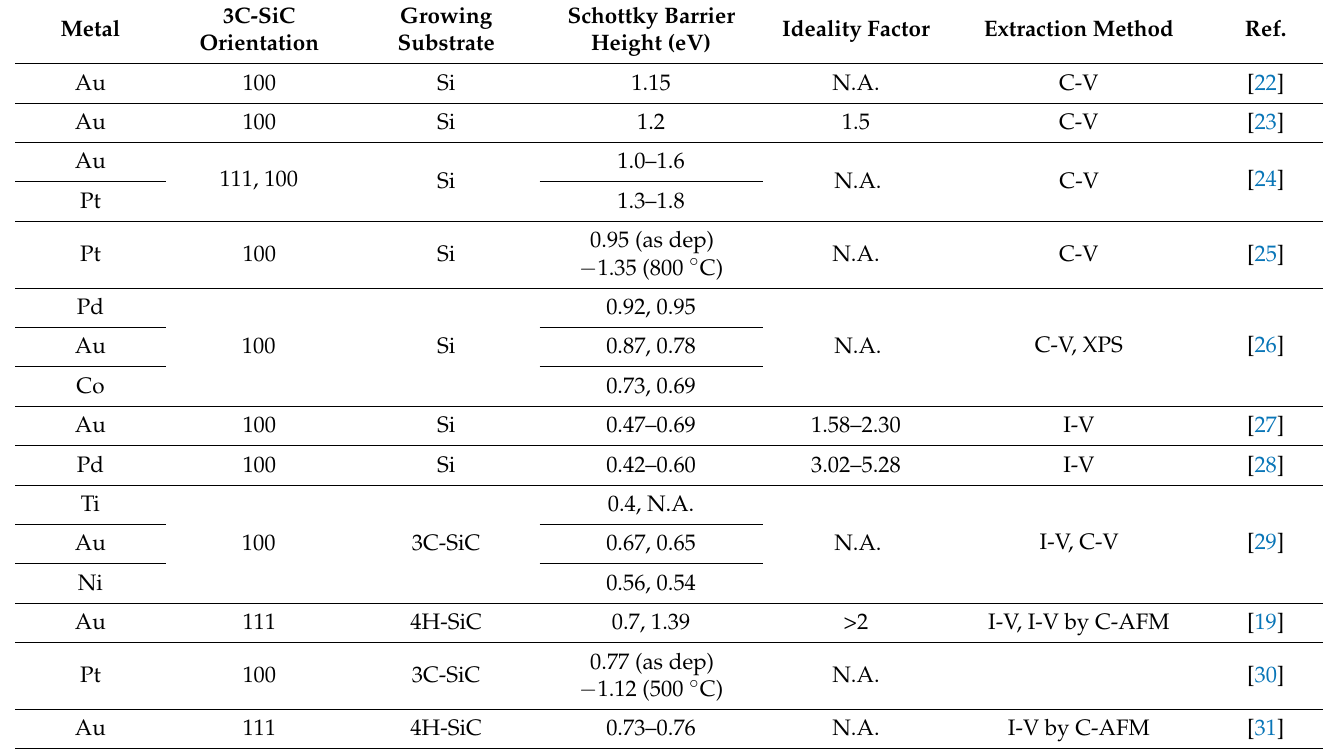
Figure 3. ( a ) Schematic of the C-AFM set-up to probe Pt/3C-SiC Schottky diodes of different areas. ( b ) Percentage of the diodes (yield) with a reverse leakage lower than 10 µ A cm − 2 , as a function of diode area. ( c ) Schematic of the C-AFM set-up to probe the 3C-SiC surface and current maps acquired under forward bias ( d ) and reverse bias ( e ). Adapted with permission from Ref. [21]. Copyright © 2021 Wiley VCH. Table 2. Collection of literature results on Schottky contacts on 3C-SiC